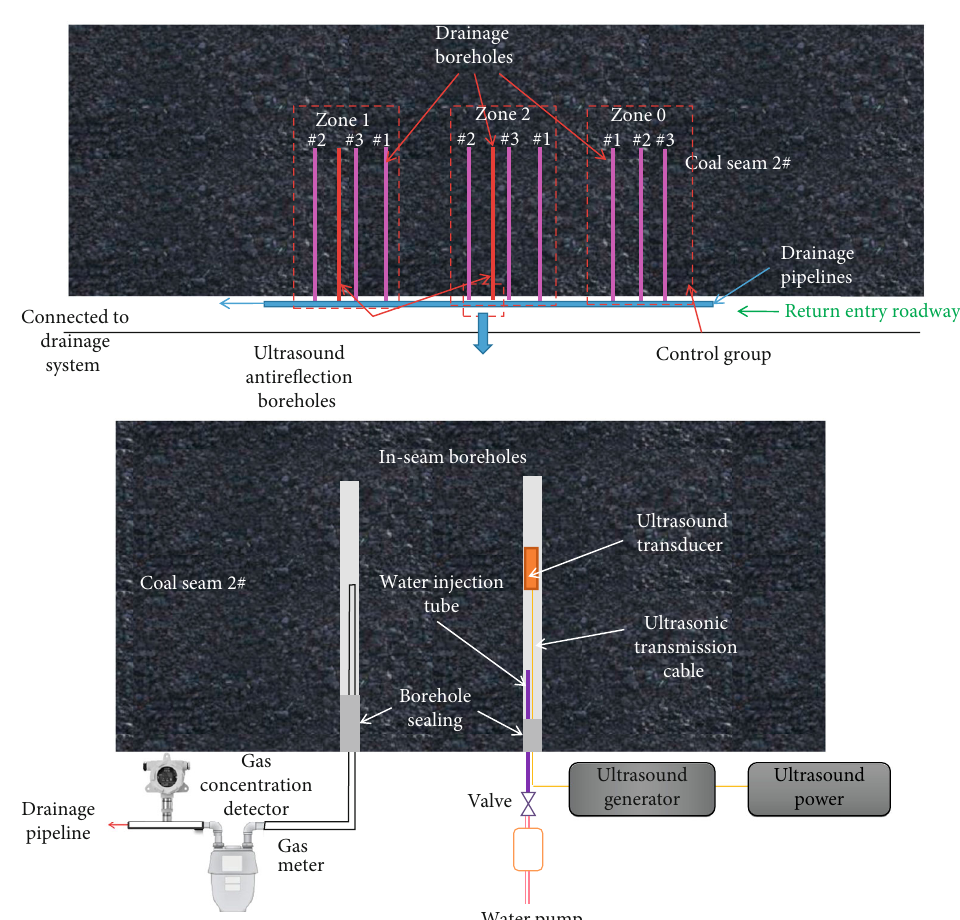
Figure 2: Schematic diagram of the in situ layout of the fi eld